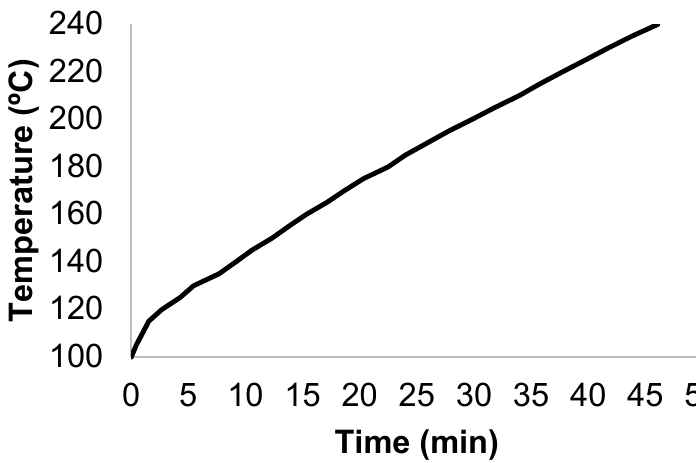
Figure 1. Temperature profile that was followed in autohydrolysis experiments.